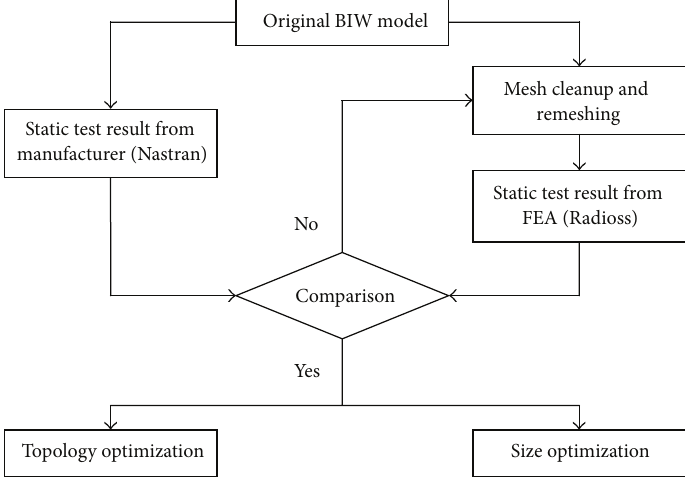
Figure 2: Flow diagram for BIW model optimization strategy.